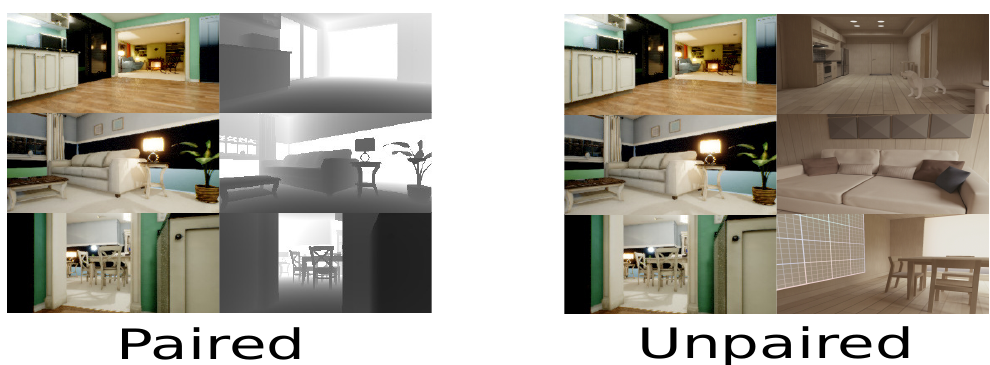
Figure 3. Type of samples for the known paired domain and the unknown domain unpaired. The paired samples have a 2D image and depth data to calculate the occupied obstacles. On the other hand, unpaired samples have two principal samples for indistinct